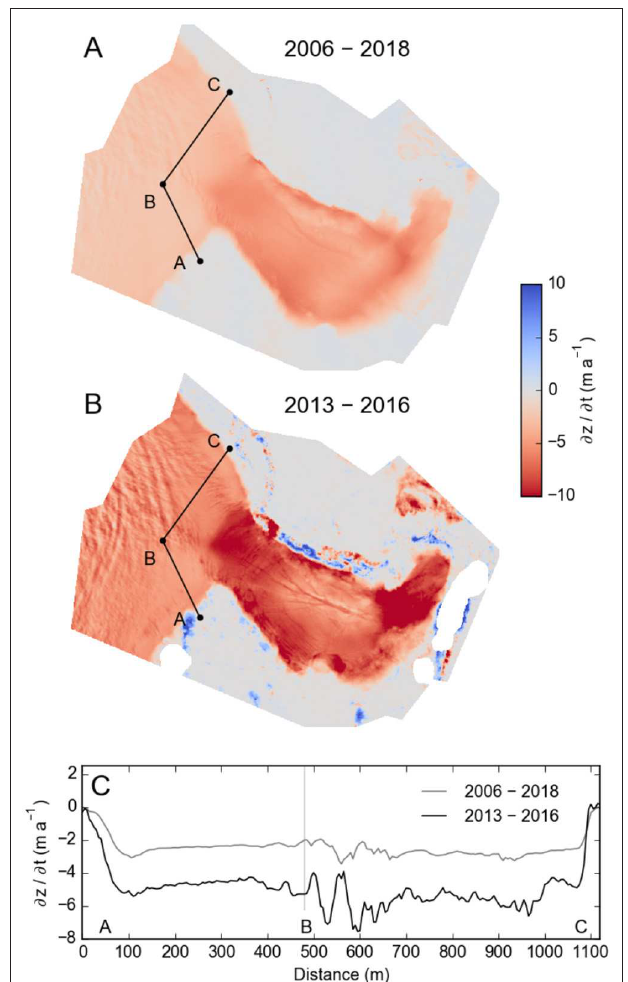
FIGURE 5 | (A) Annual elevation changes ( ∂ z /∂ t ) derived from differencing the Lidar-derived DEM from 29 April 2018 and the aerial photo-derived DEM from 3 July 2006. The black line shows the transect along which the elevation change is sampled in (C) . (B) Annual elevation changes derived by differencing a WV3-derived DEM from 21 August 2016 and a WV2-derived DEM from 28 July 2013. Dark blue and red areas outside the glacier perimeter are due to DEM artifacts that occur mostly in steep terrain. White areas represent no data in the original DEMs. (C) Elevation changes sampled along the transect A–B–C across the basin entrance. Note the stronger thinning between B–C compared to A–B, caused by dynamic thinning due to ice flow into the